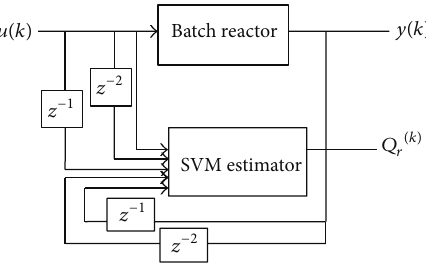
Figure 3: Simulated actuator fault by introducing bias at the time of 80 minutes.